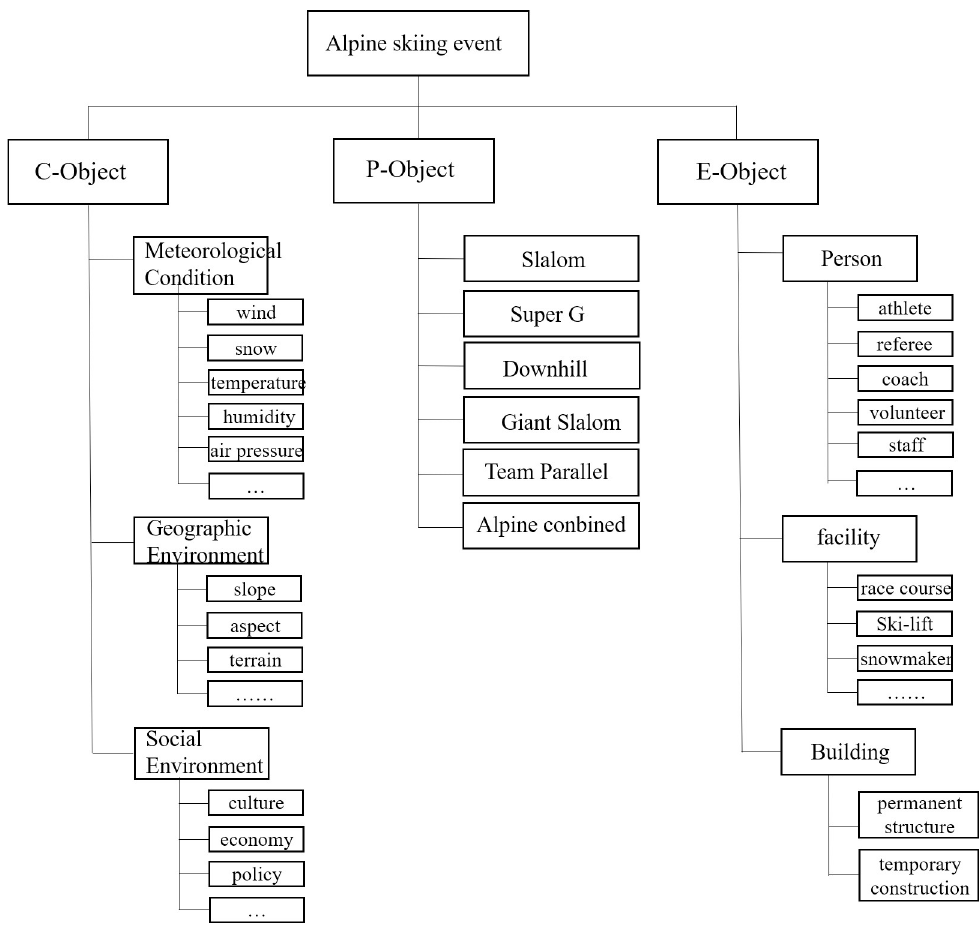
Fig 3. Object classification of alpine skiing